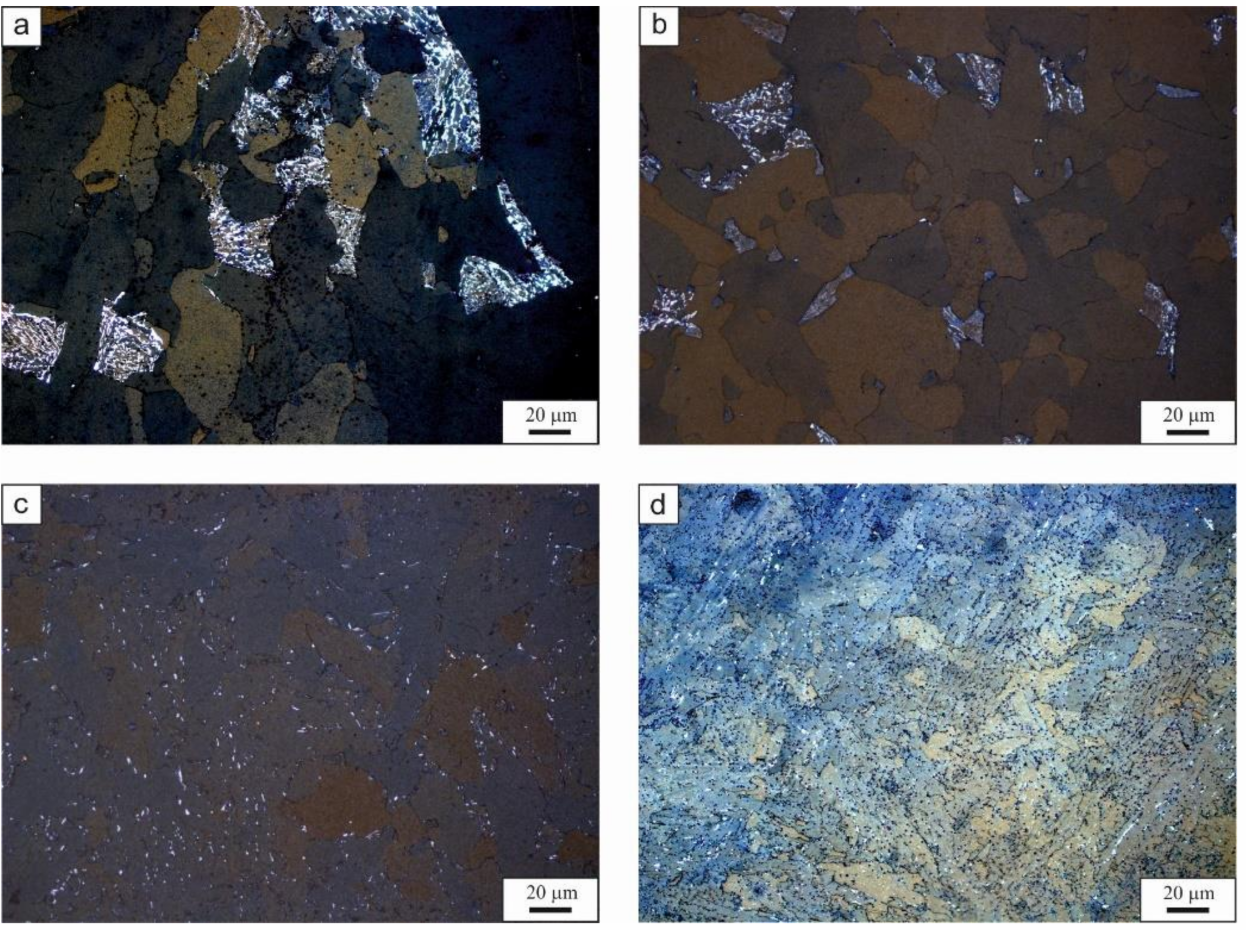
Figure 7. The microstructure after Klemm etching for: ( a ) 0.1 ◦ C/s, ( b ) 1 ◦ C/s, ( c ) 8 ◦ C/s, ( d ) 60 ◦ C/s. The white phase is retained